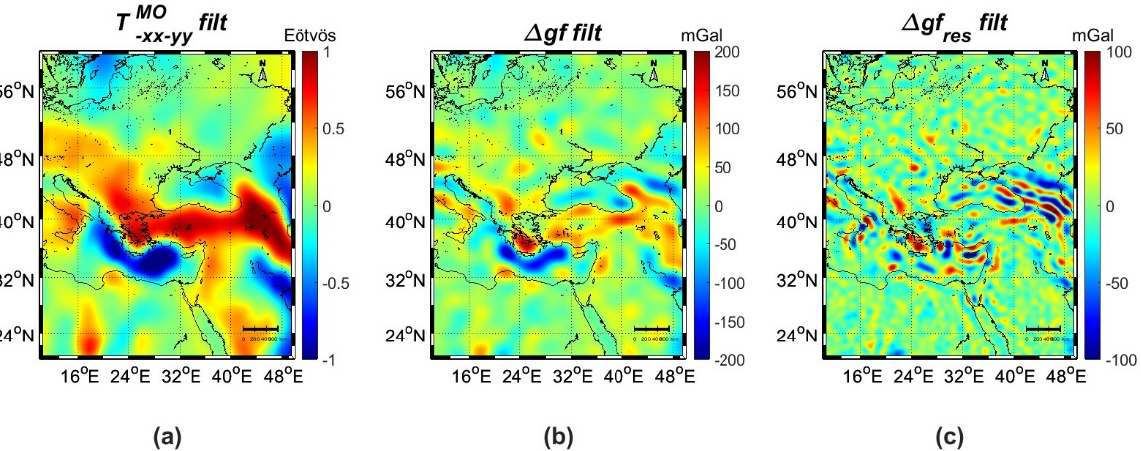
on earth’s surface ( ∆ gf filt ) , ( c ) their residuals ( ∆ gf res filt ) with the ground data based on TIM_R6 d/o 300.